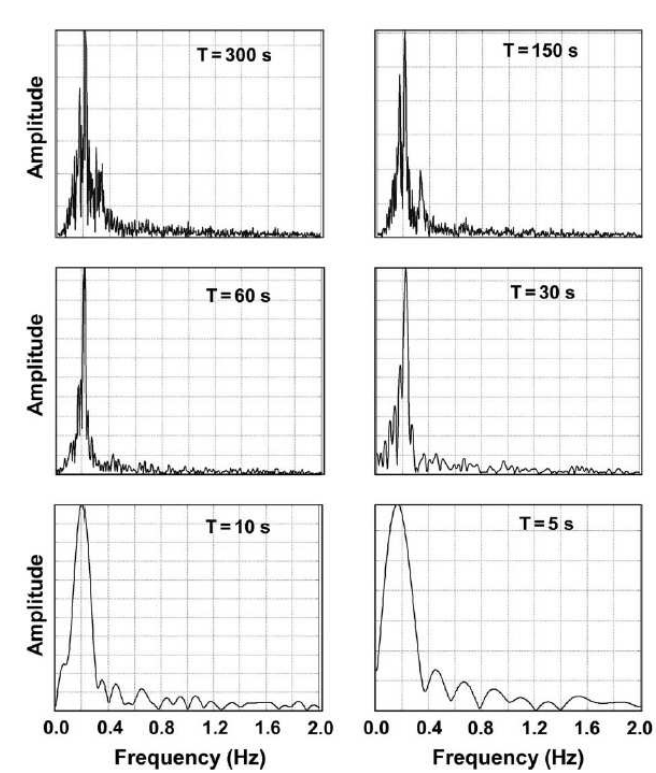
Figure 14. Breathing rate of a person in a face up posture at different time resolutions